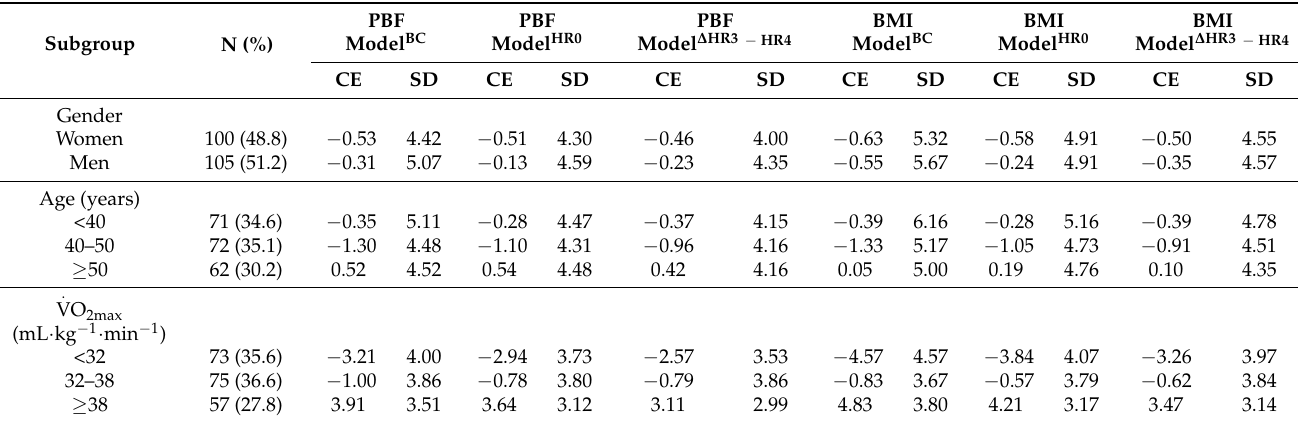
Table 4. Constant error and standard deviations for subgroups of gender, age, and measured V ( n = 205).